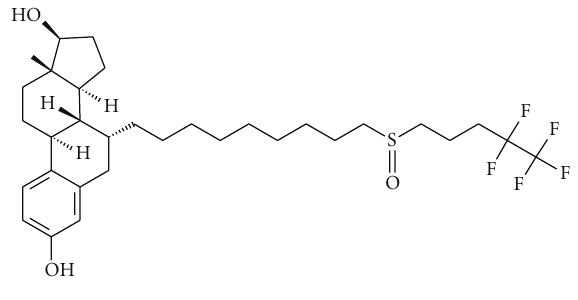
Scheme 1: Chemical formula of